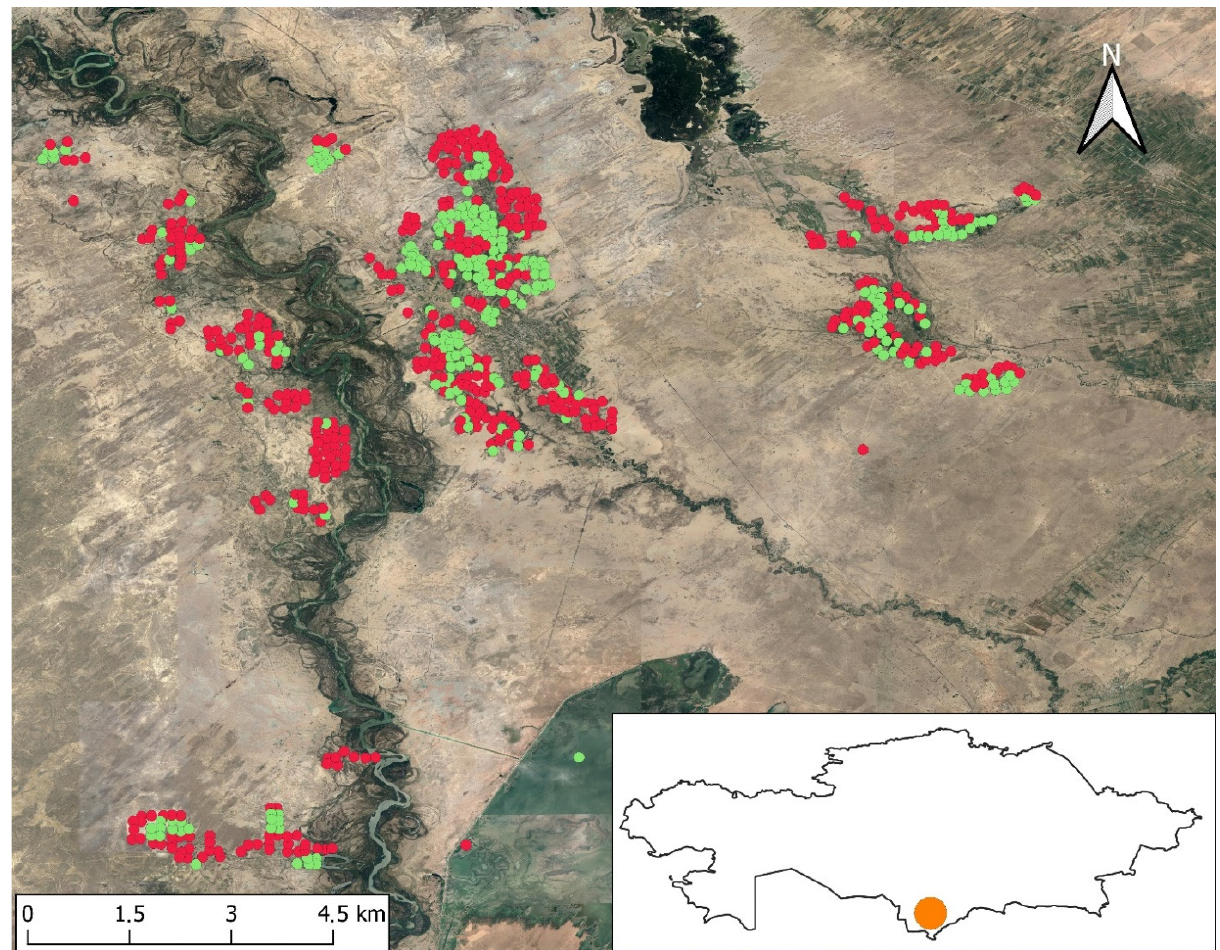
Figure 1. Map of the Syr Darya basin and localization of the study sites. Cultivated soils are marked with green dots, and uncultivated soils with red dots.